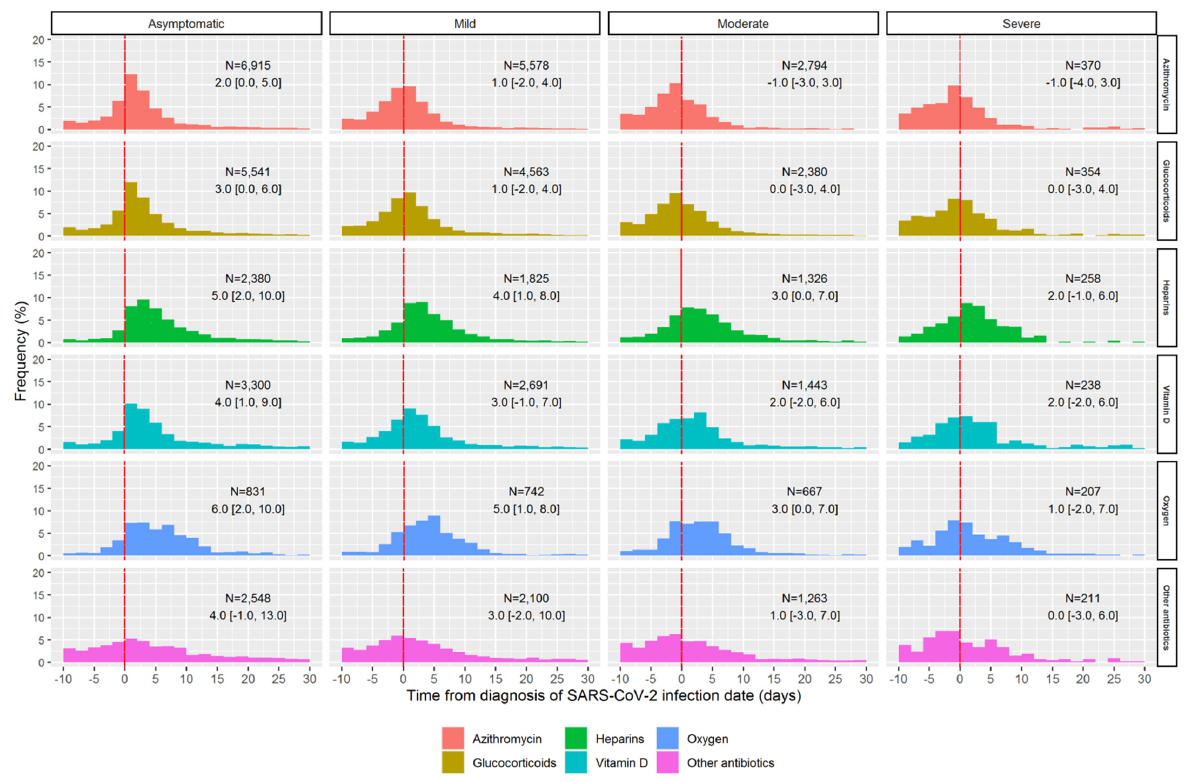
Figure 6. Distribution of the time elapsed between the date of the first laboratory-confirmed SARS-CoV-2 infection diagnosis and the date of the first pharmacy claim, stratified by study drugs/drug classes and symptoms at the SARS-CoV-2 diagnosis among incident drugs users. Note: The number of users (N) and the median (along with IQRs) of elapsed days are reported within each plot, respectively.